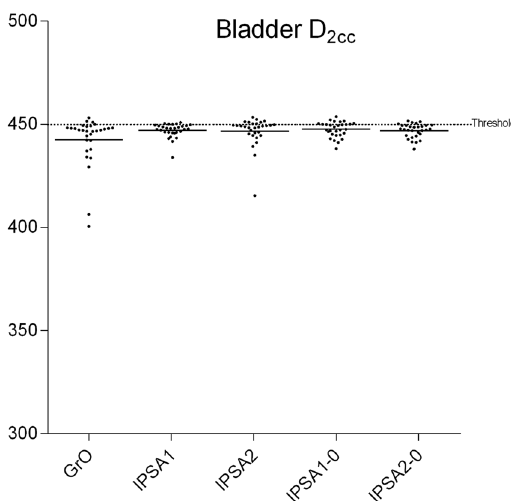
Figure 3. Comparison of bladder D 2cc among different